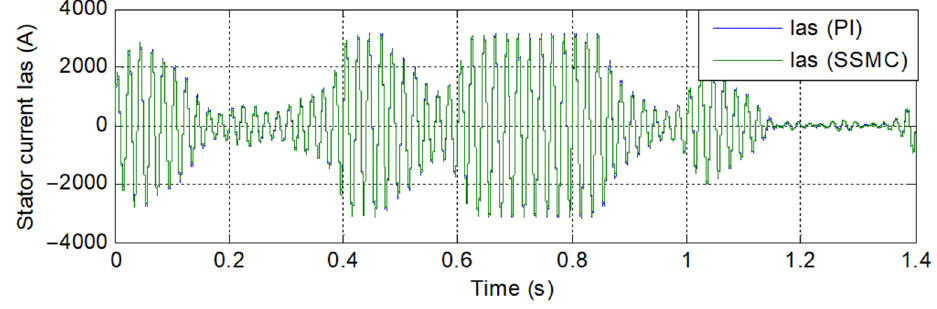
Figure 8. Torque.